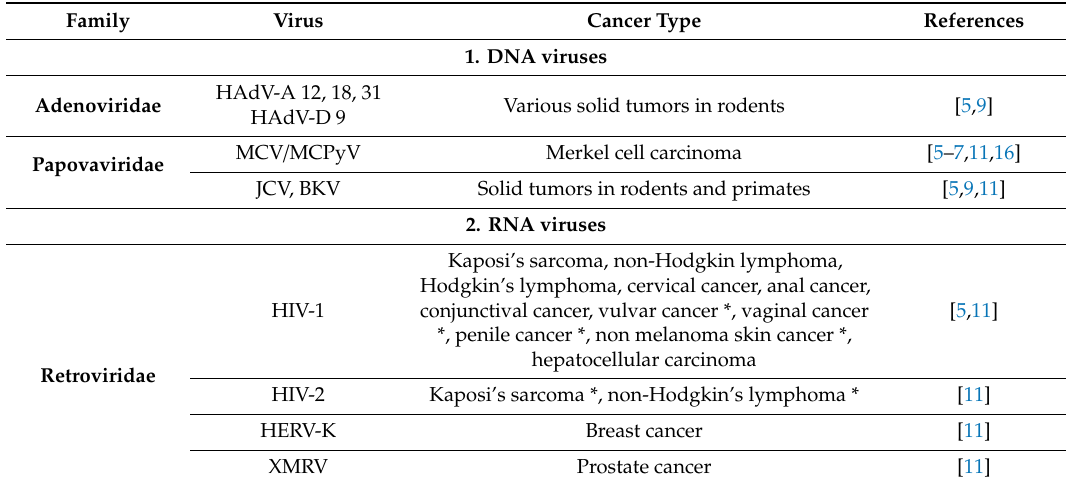
Table 2. Potentially oncogenic human